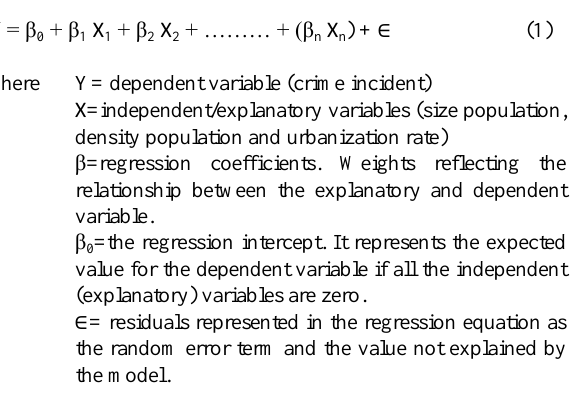
Table 1: EHSA workflow using Model Builder ArcGIS Pro 2.4 The OLS regression were calculated using standard equation;